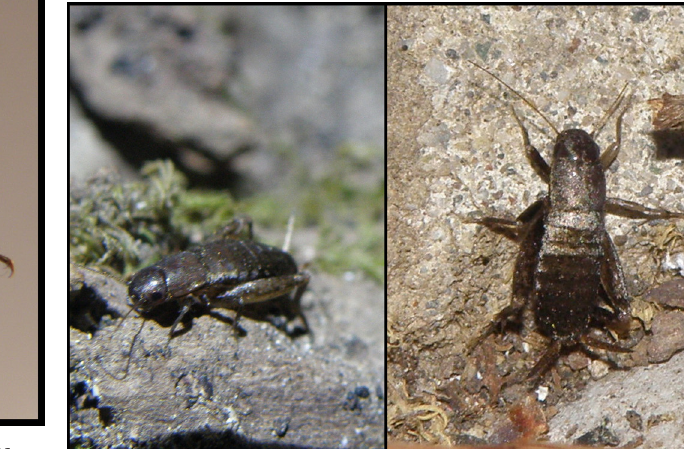
Figure 10. Eumodicogryllus bordigalensis bordigalensis , Attiki, Vrav- rona, Erasinos river, X 2012. A . frontal view of the head, B . lateral view (scale bar: 5 mm).